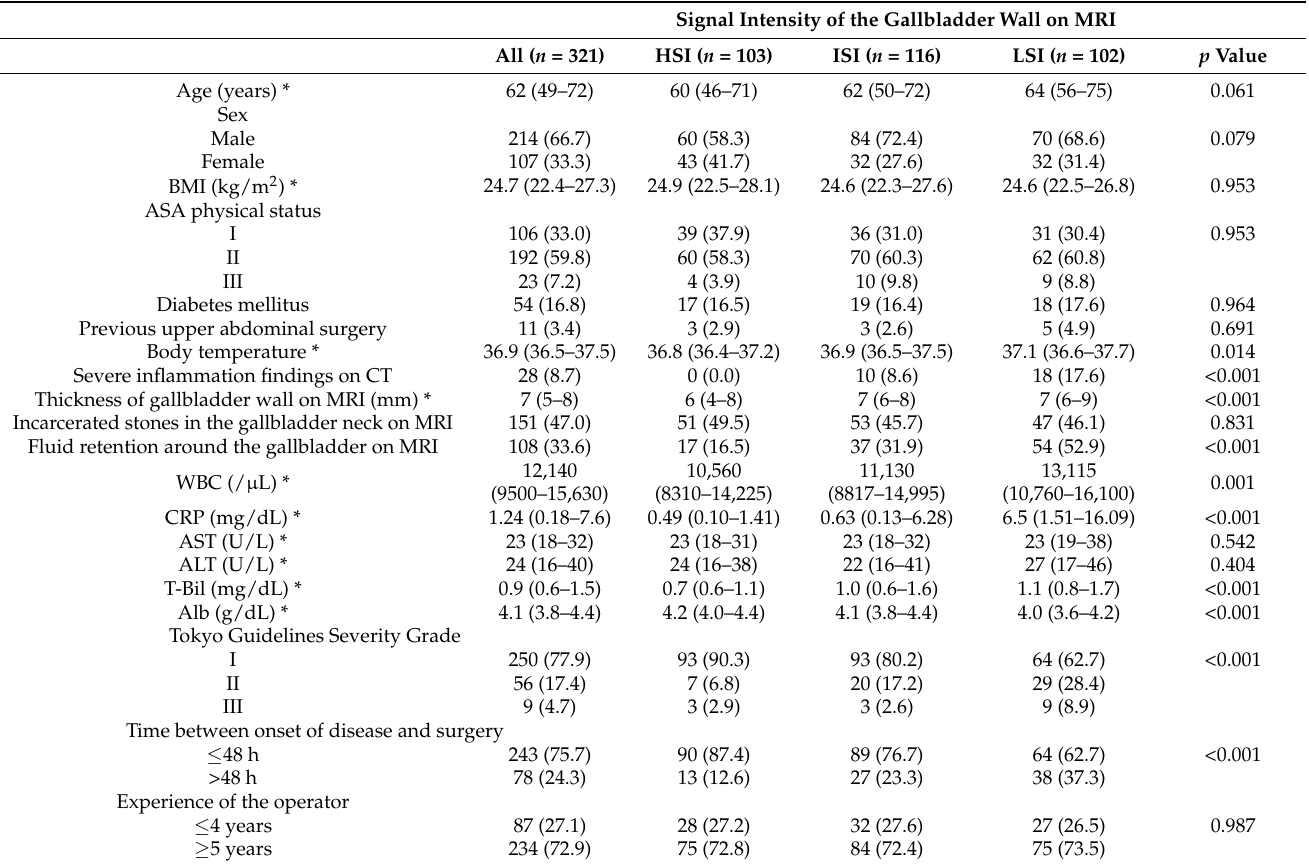
Table 1. Characteristics of the three